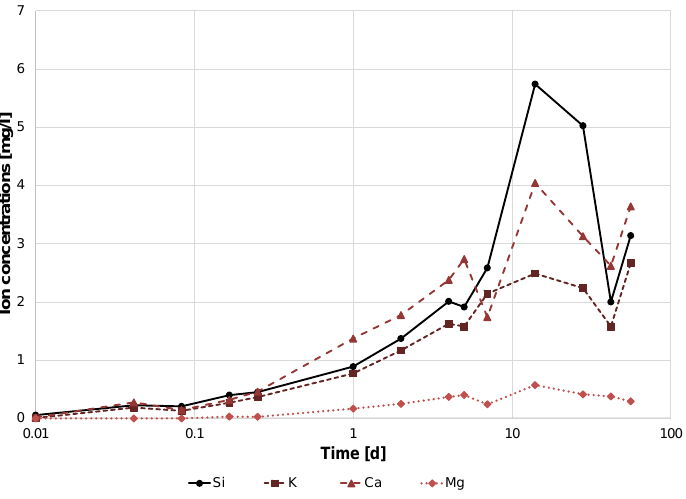
Figure 7. Ion concentration in deionised H 2 O in relation to time for glass 1-06. The concentration of silicon ions increased up to a maximum at a storage period of 14 days. Thereafter, the Si 4+ ion concentration decreased again. The Ca 2+ and K + ion concentrations also increased up to the storage period of 14 days and then decreased again. The reduction of the ion concentrations can also be attributed here to the formation of poorly soluble compounds. Only the concentration of magnesium ions increased very slowly and